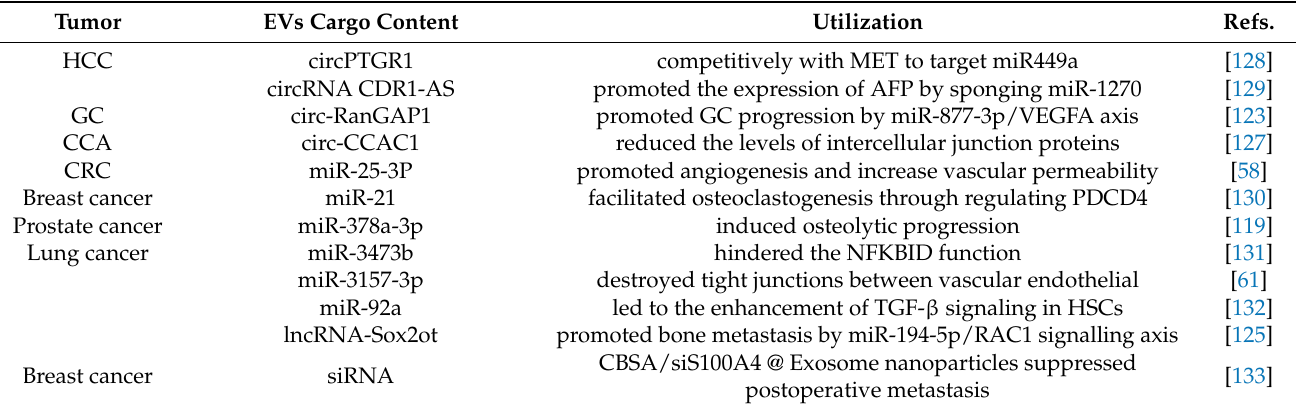
Table 2. Targeted intervention in tumor metastasis of ncRNAs carried by